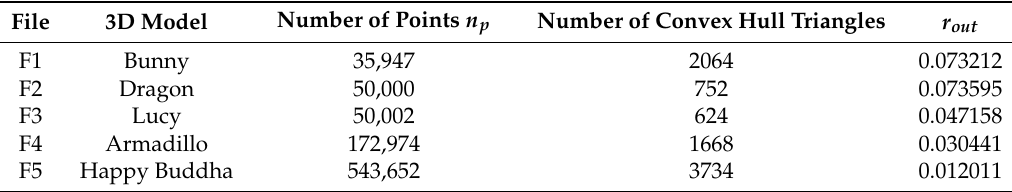
Table 2. 3D point clouds used in